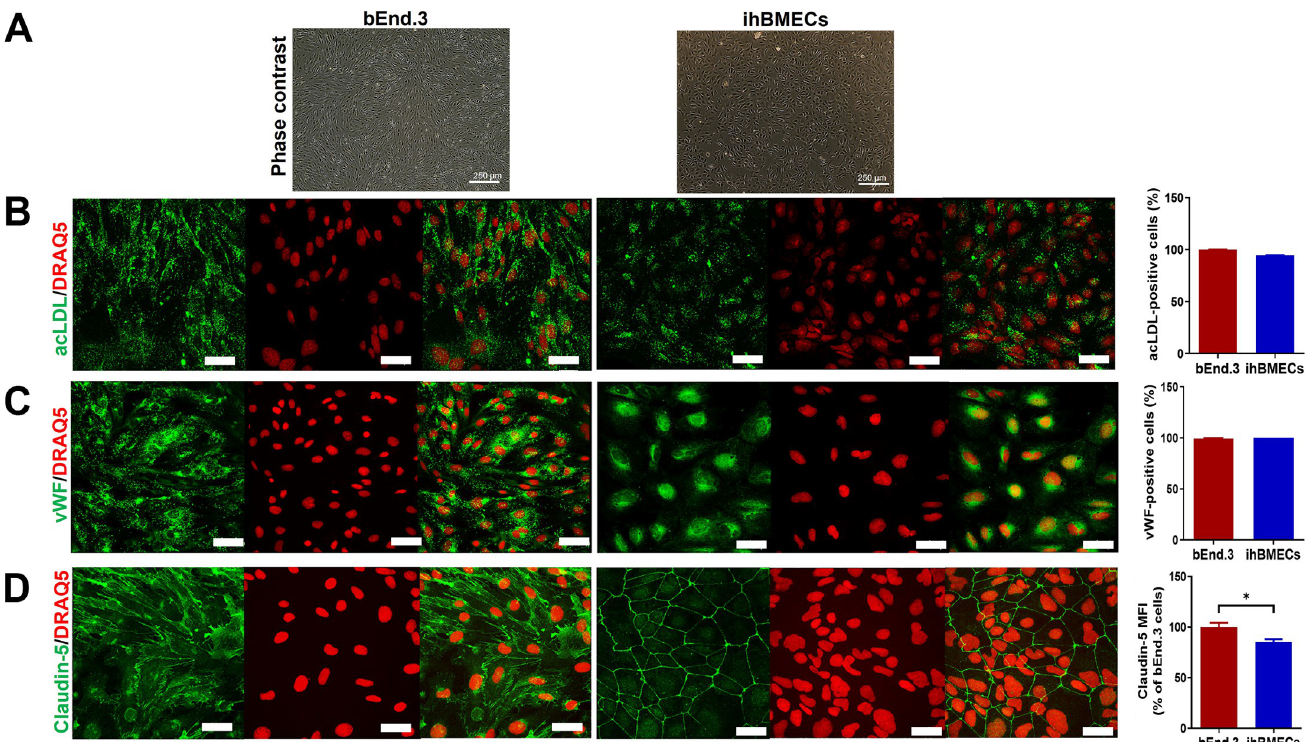
Fig 3. Endothelial phenotypic confirmation of bEnd.3 cells and ihBMECs. Phase-contrast images showing the typical cobblestone morphology of the bEnd.3 and ihBMECs ( A , scale bar = 250 μ m). Uptake of AlexaFluor-488 labeled acetylated low-density lipoprotein (acLDL) by the bEnd.3 cells and ihBMECs (shown as green in B ). Immunofluorescent detection of Von Willebrand factor (vWF) (shown as green in C ) and claudin-5 (shown as green in D ) in bEnd.3 cells and ihBMECs. The nucleus is stained with DRAQ5 (shown as red). Scale bar = 40 μ m. Data are presented as mean ± SEM of n = 3 independent repeats. � p < 0.05 by Student’s